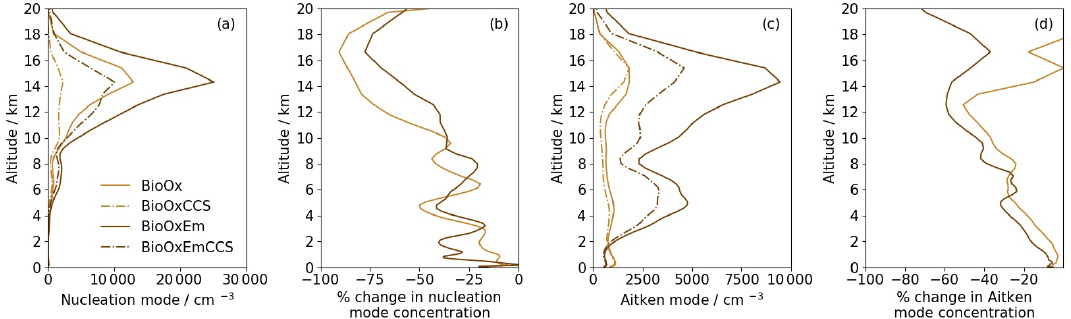
Figure 7. Regional domain-averaged profiles from the BioOx, BioOxCCS, BioOxEm and BioOxEmCCS simulations. Shown are the nucle- ation and Aitken mode aerosol number concentrations ( a and c ) and the percentage changes in nucleation and Aitken mode aerosol number concentrations due to the introduction of the cloud condensation sink ( b and d